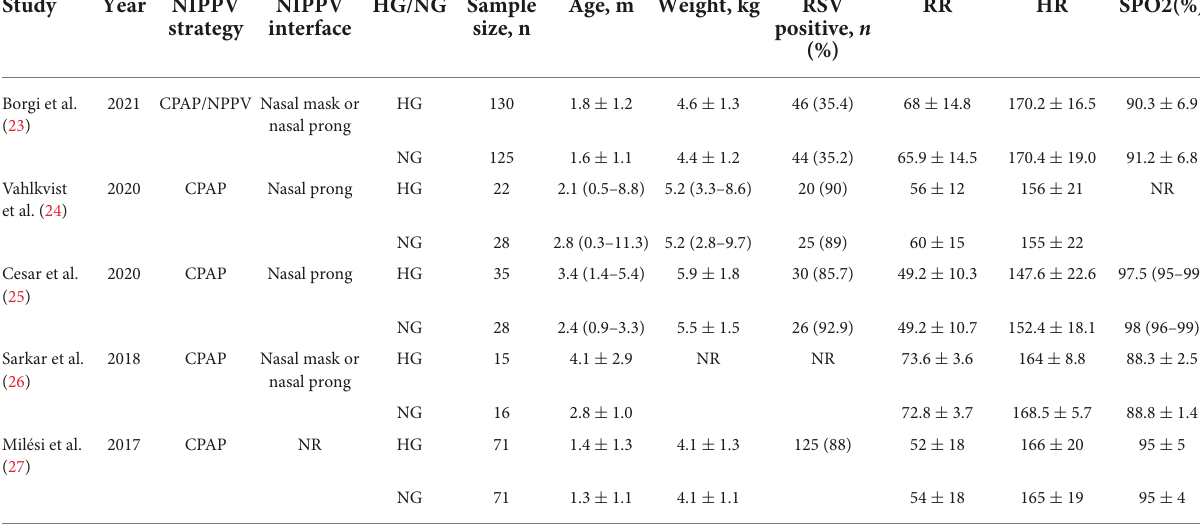
TABLE 1 Characteristics of included studies.